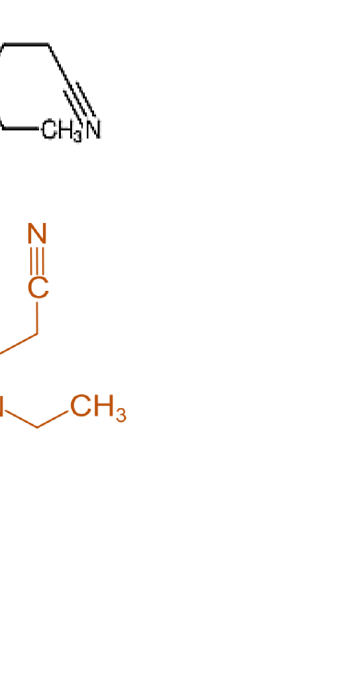
Figure 1. Disperse orange